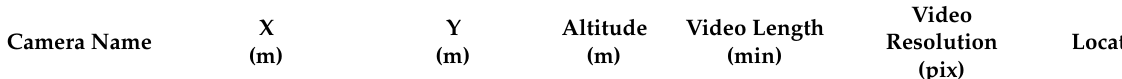
Table 1. The experimental data.